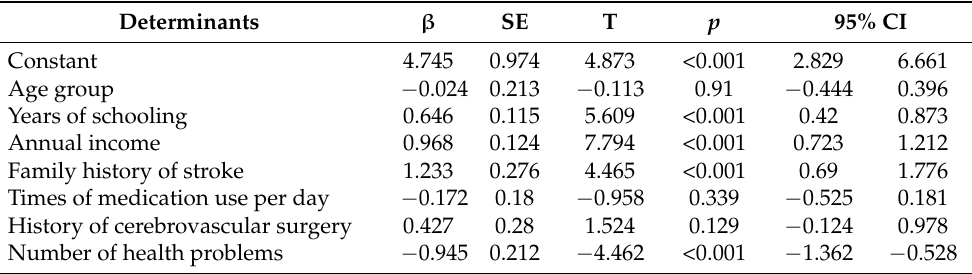
Table 4. Results of multiple linear regression analysis of determinants of medication literacy in patients with stroke (N =